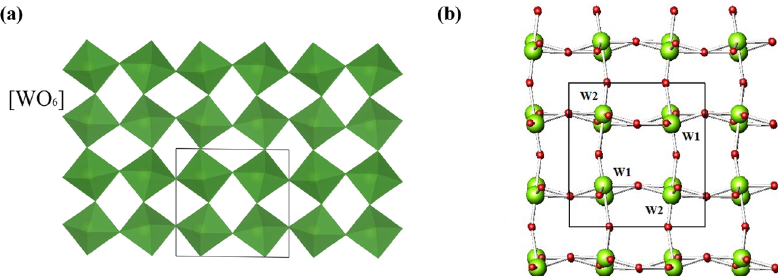
Figure 11. The crystal structure of liguowuite. [WO 6 ] octahedra are shown in green. Green and red balls correspond to W and O atoms,